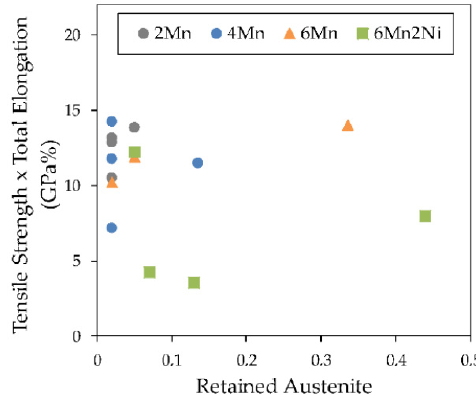
Figure 10. Relationship between the product of tensile strength and total elongation with retained austenite in the Q&P processed steels.